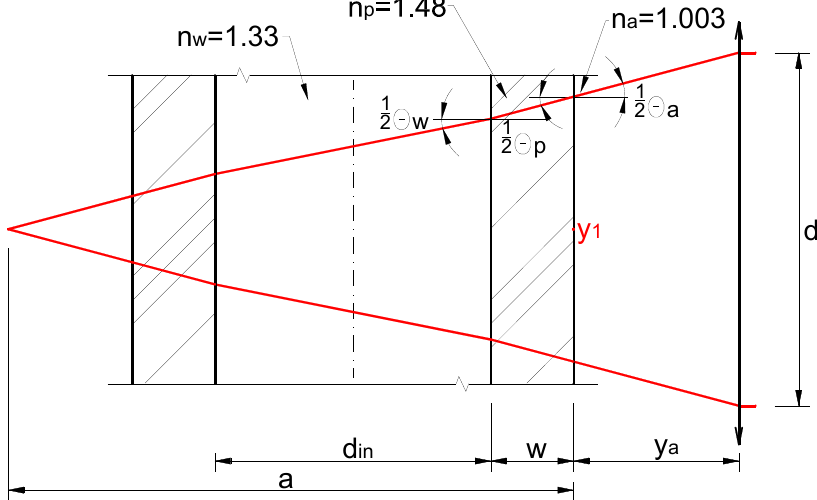
Figure 4. A fragment of the horizontal cross-section in the experimental space.